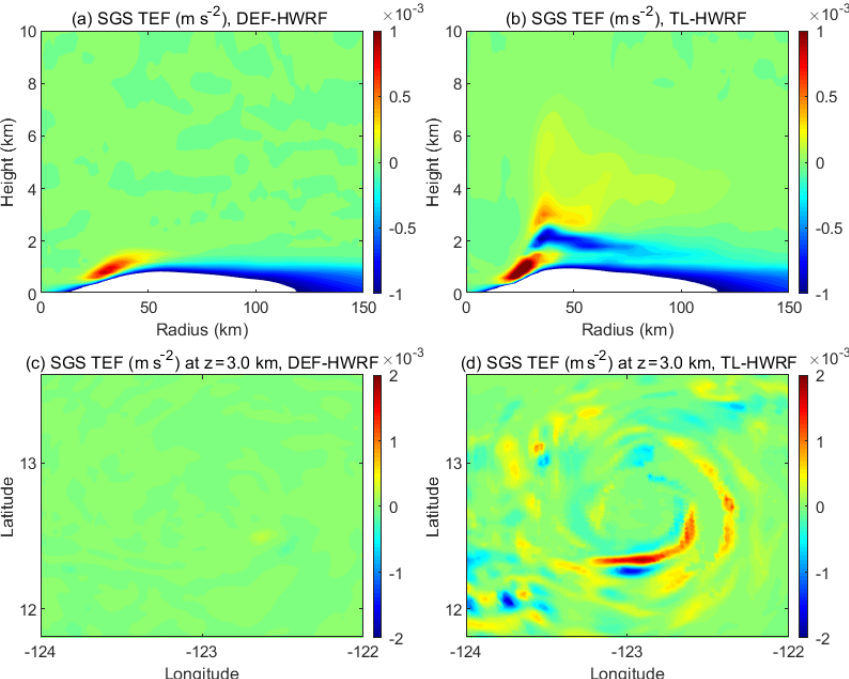
Figure 11. SGS tangential eddy forcing (TEF) averaged over Jimena’s RI period from 06:00UTC, 28 August, to 06:00UTC, 29 August 2015, from the two HWRF simulations (DEF-HWRF and TL-HWRF). (a, b) Azimuthal-mean radius–height structure of SGS TEF. Note that the SGS TEF smaller than − 1 . 0 × 10 − 3 (ms − 2 ) is shaded in white for a clear illustration of SGS TEF above the PBL. (c, d) Horizontal structure of SGS TEF at 3km